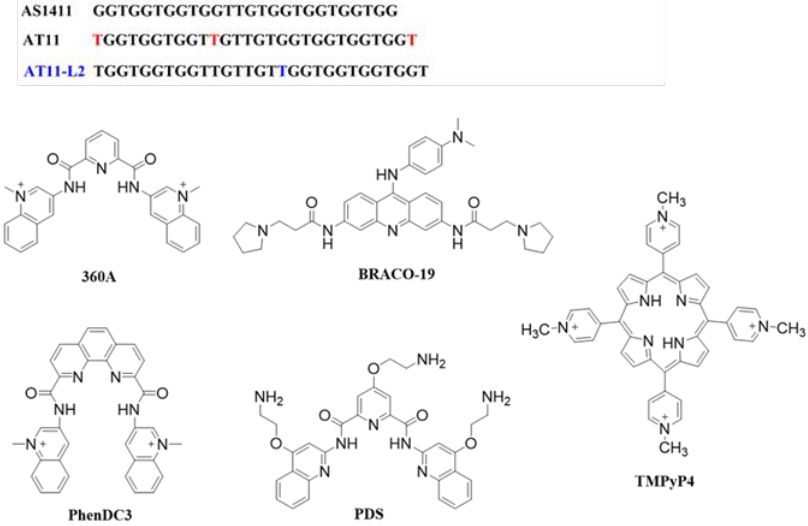
Figure 1. AS1411 derivatives and chemical structure of G4 ligands.